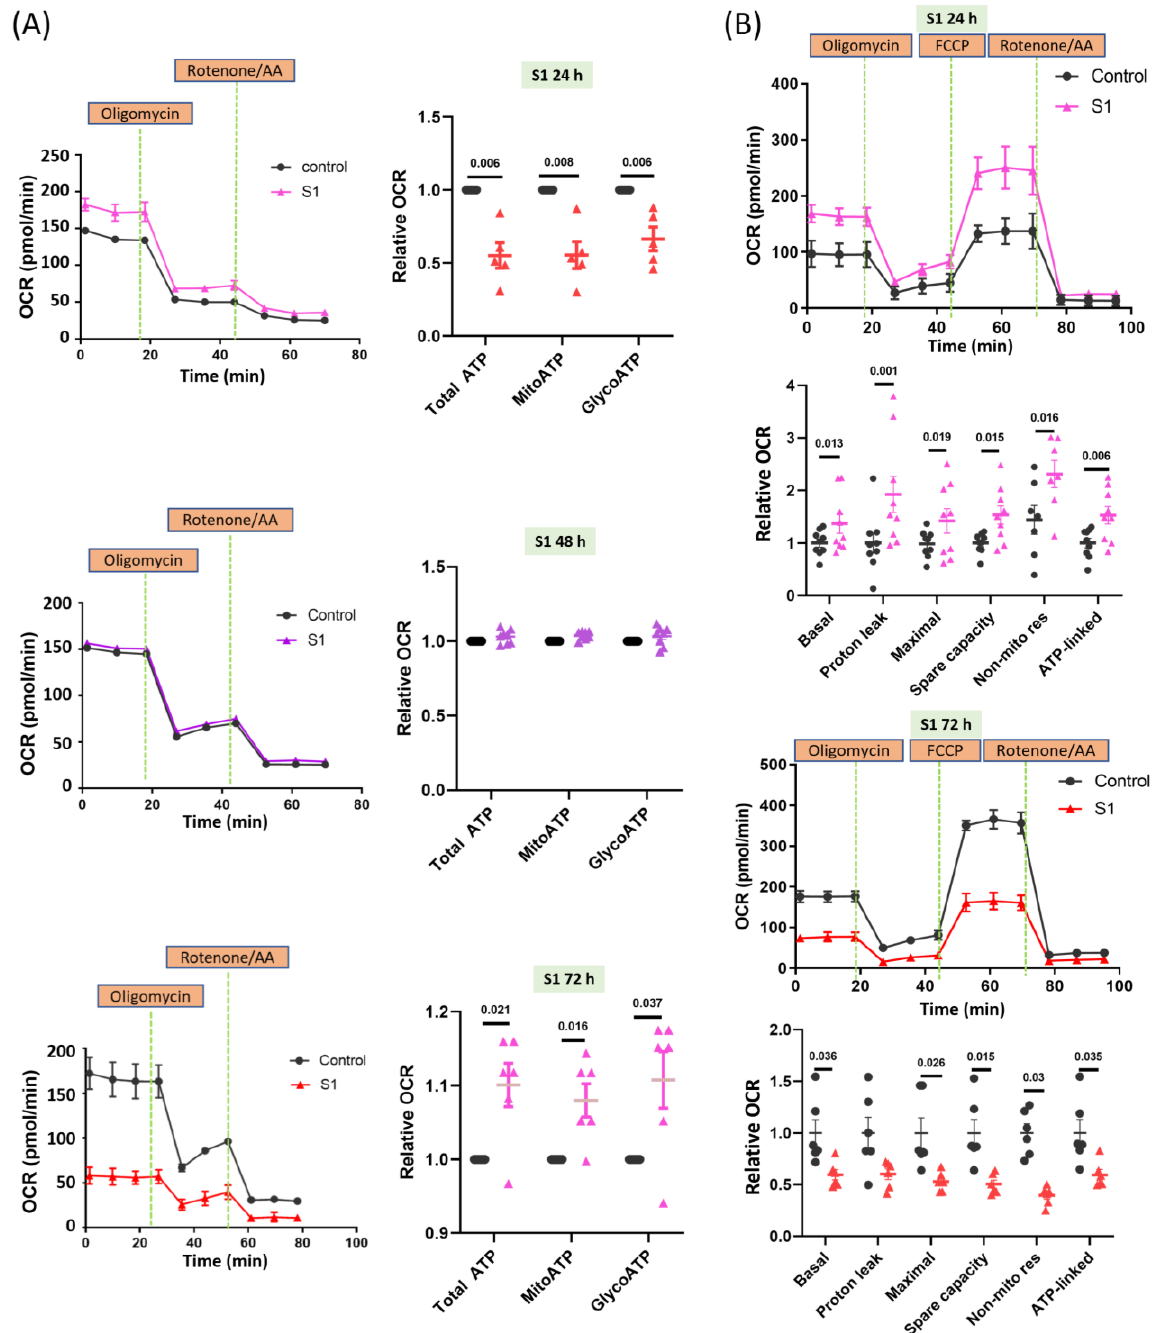
Figure 1. Effects of S1 treatment at different durations on ATP synthesis in AC16 cells. ( A ) Seahorse real-time ATP rate assay showed that ATP production in AC16 cells was increased at 24 h,